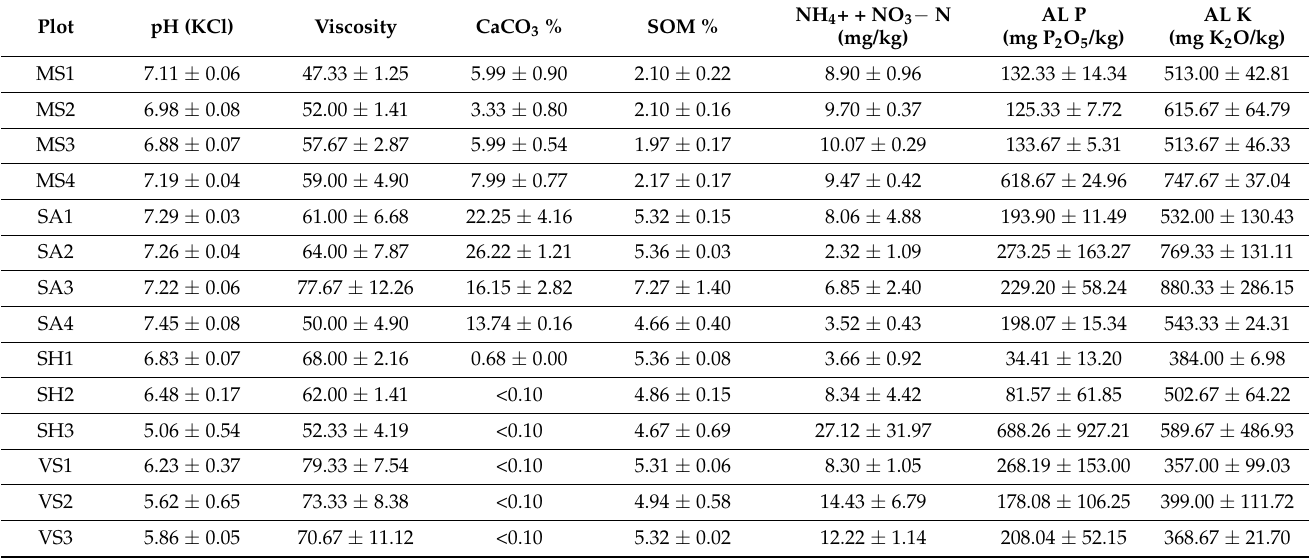
Table A2. Measured soil parameters in the examined shelterbelts.